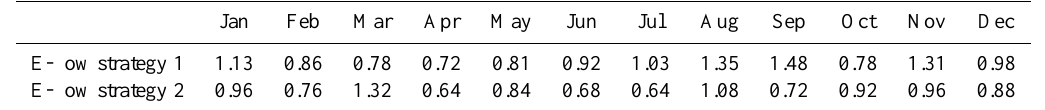
Table 3. Optimised value of k for each month for the Wangkuai Reservoir (kwhRMB − 1 ). Jan Feb Mar Apr May Jun Jul Aug Sep Oct Nov Dec